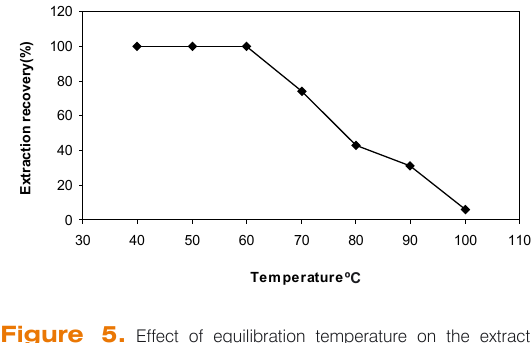
Figure 5. Effect of equilibration temperature on the extraction recovery of Au. Conditions: 100 ng mL -1 Au,